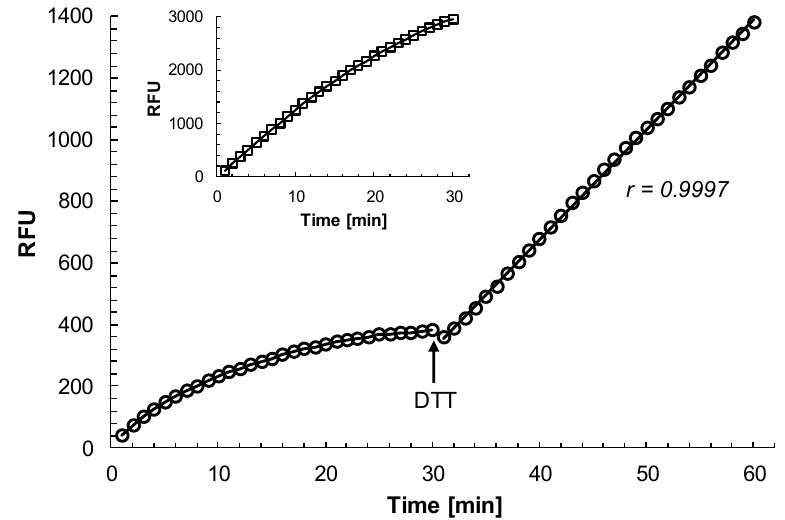
Figure 5. E ff ect of curcumin on substrate hydrolysis of rhodesain in the absence of the thiol dithiothreitol. Purified rhodesain (35 ng / mL; 1 nM) was incubated with 6 µ M curcumin (circles) in 100 mM citrate, pH 5.0, 2% DMSO, in the presence of 5 µ M of the fluorogenic substrate Z-FR-AMC. After 30 min, dithiothreitol (DTT) was added to a final concentration of 2 mM (arrow). r, correlation coe ffi cient of the trend line. Insert, substrate hydrolysis of rhodesain in the absence of curcumin and dithiothreitol (squares). The release of free AMC was recorded every minute for 30 and 60 min, respectively. A representative experiment out of three is shown.